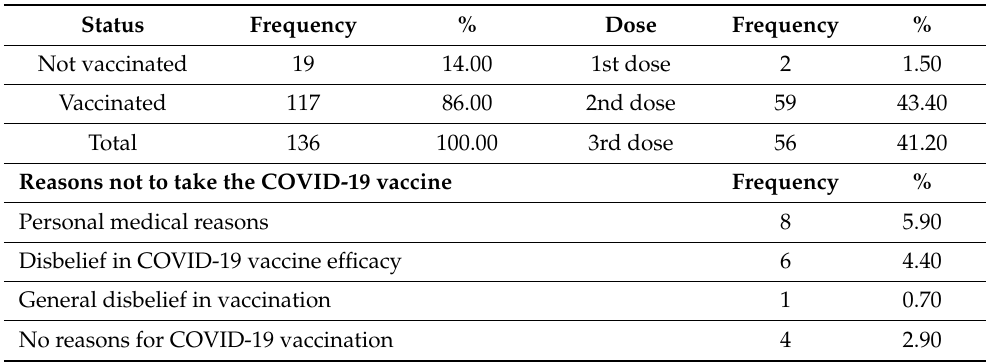
Table 3. Differences in COVID- 19 symptoms between the 2020 and 2022 sample . Table 4. COVID 19 vaccination status in the 2022